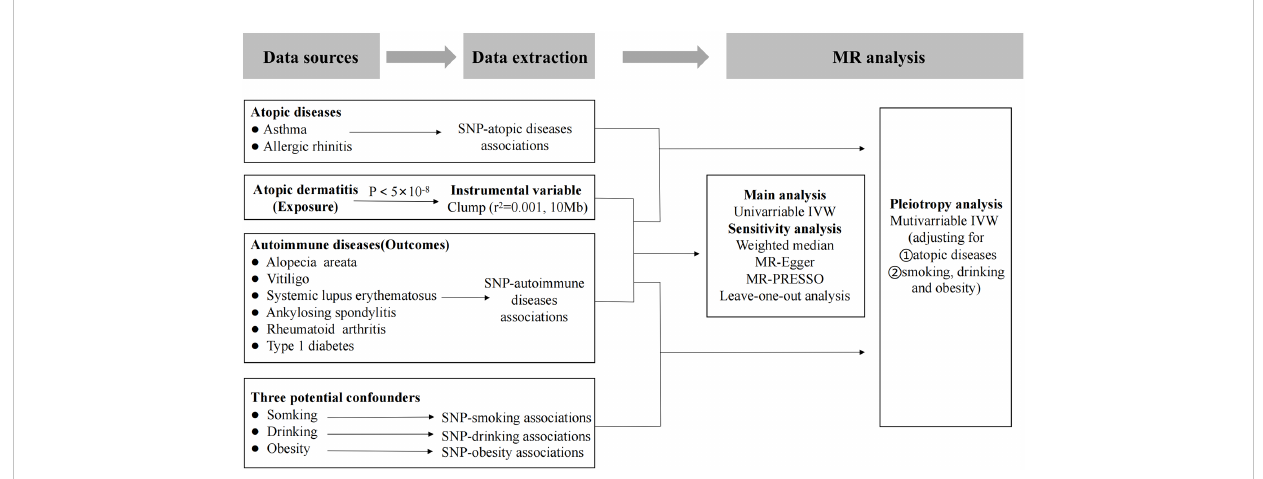
FIGURE 1 Flow chart of the study design and the process of MR analysis. MR, Mendelian randomization. MR-PRESSO, MR pleiotropy residual sum and outlier test. SNP, single nucleotide polymorphism. IVW, inverse-variance